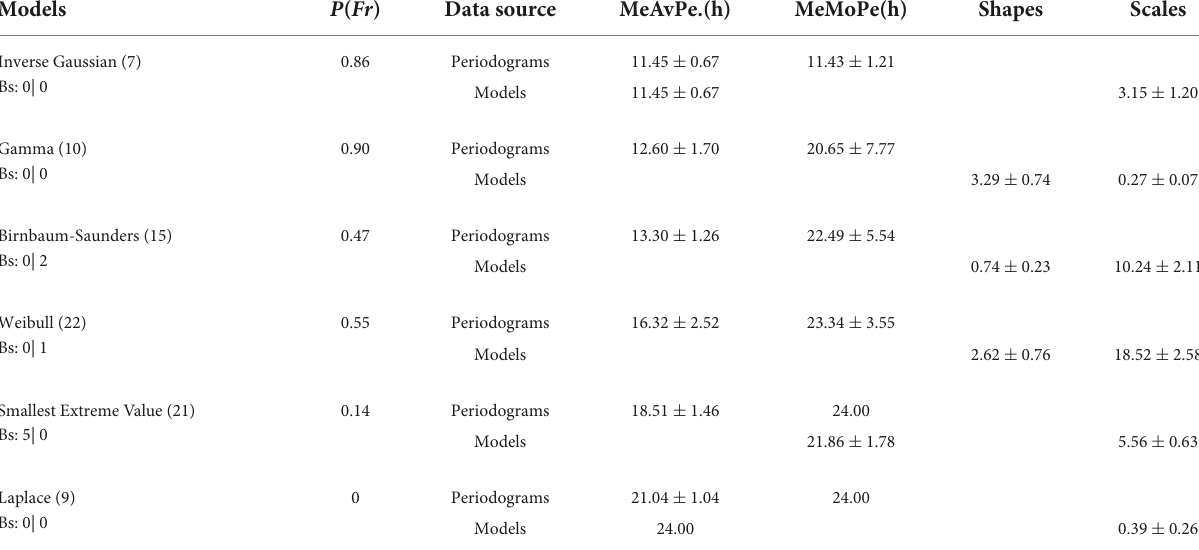
TABLE 4 Probability distributions and average periods. The number of distributions (No.). P (Fr). Sources of data, periodograms, and models. Means of the average periods (AvPe), means of the modal periods (MoPe), shapes, and scales. Bs, number of bilateral symmetries under En |